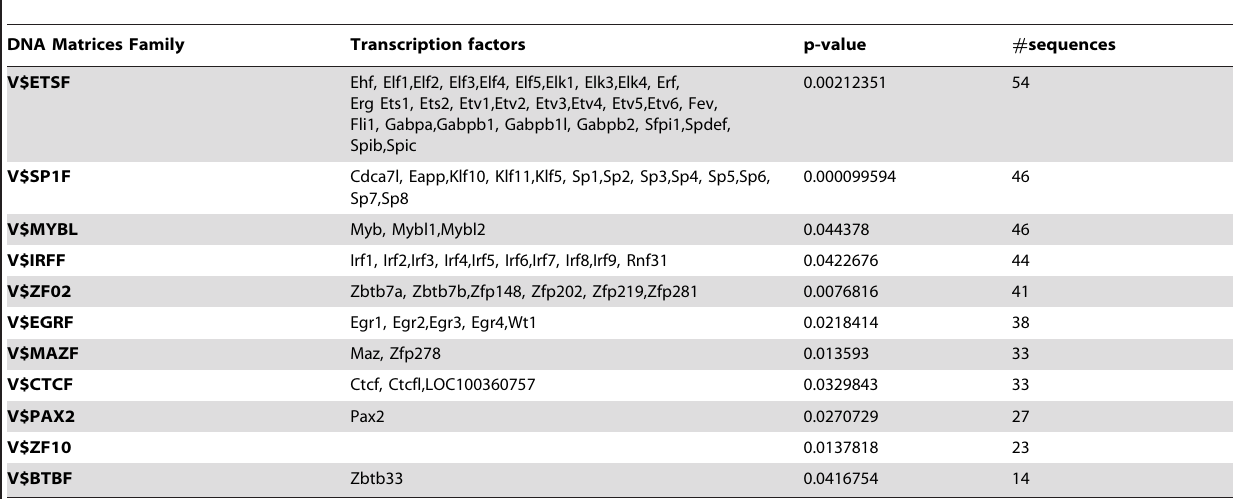
Table 8. List of Matrices Family overrepresented in the promoter sequences of the TCDD regulated genes in ovaries.